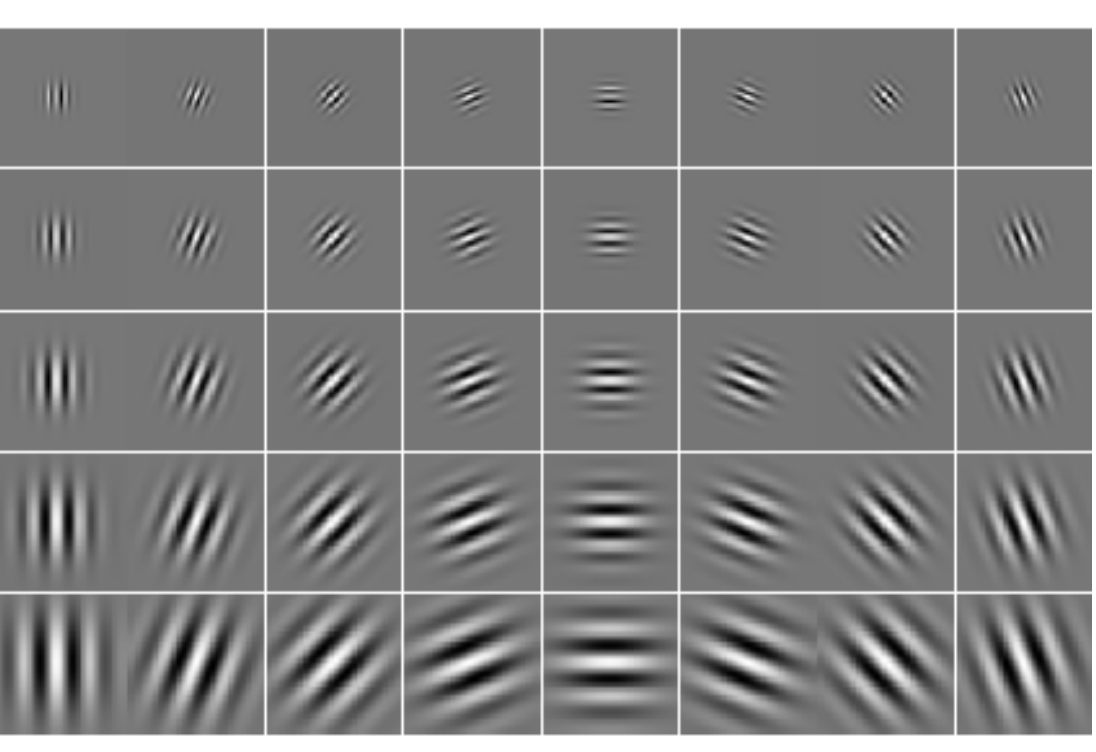
Figure 3. Real part of 40 Gabor kernels at 5 scales and 8